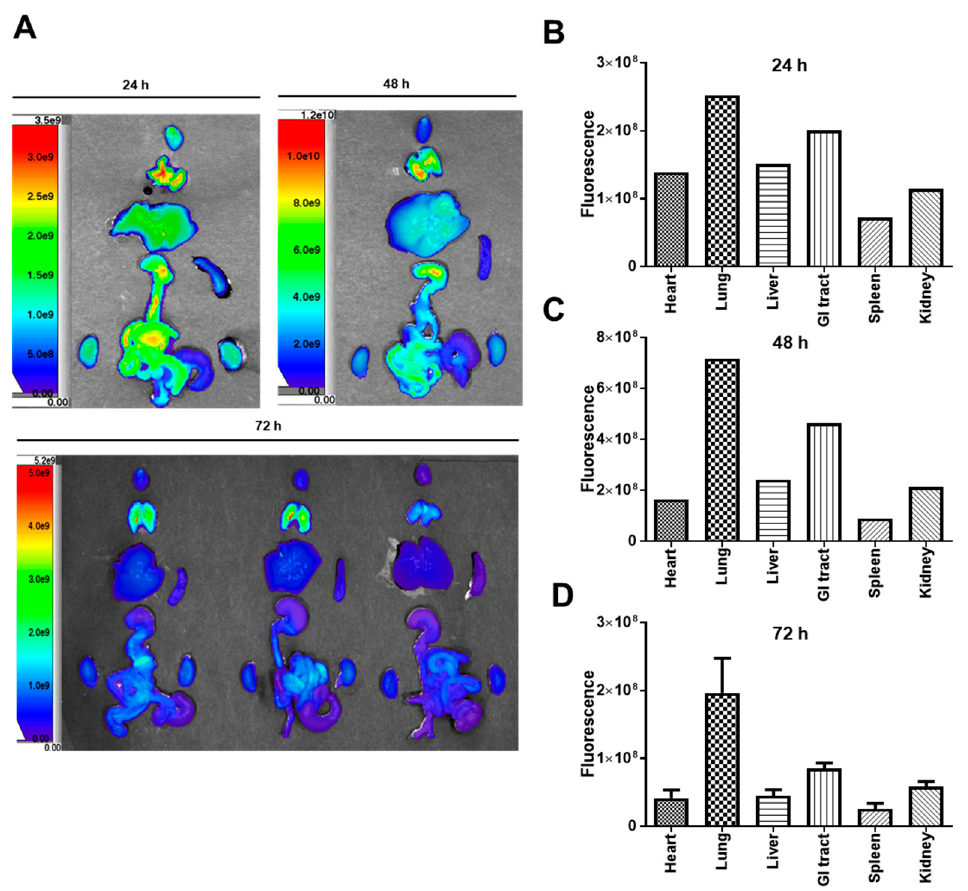
Figure 7. Ex vivo images of dehydrocostus lactone biodistribution. Flamma ® 675 thiol-conjugated dehydrocostus lactone fluorescence images of organs at each time point ( A ). Fluorescence intensity was quantified 24 ( B ), 48 ( C ), and 72 h ( D ) after dehydrocostus lactone injection.